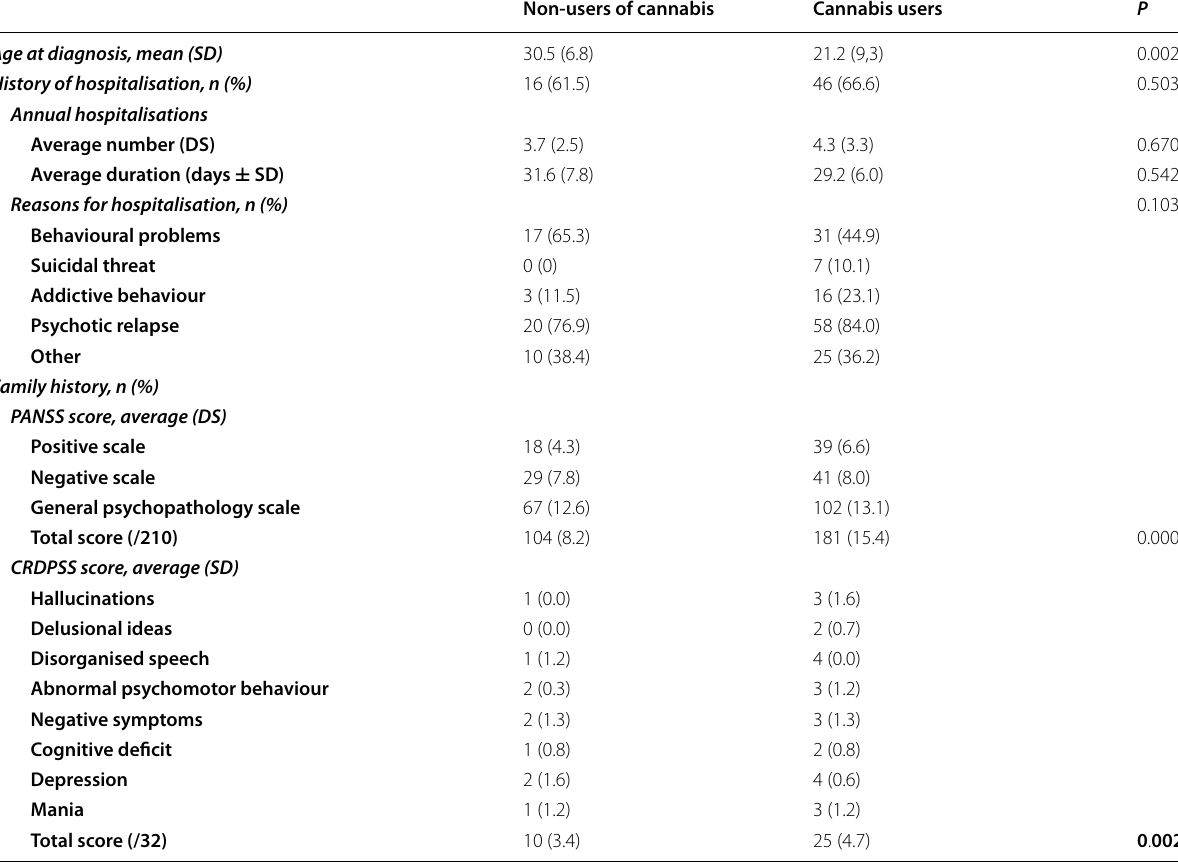
Table 3 Clinical characteristics of schizophrenia and psychiatric history in cannabis users and non-users